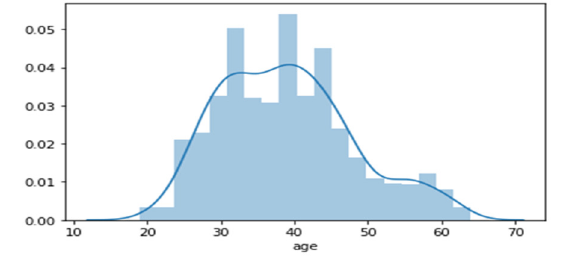
Fig. 1: Age Group of Policyholders